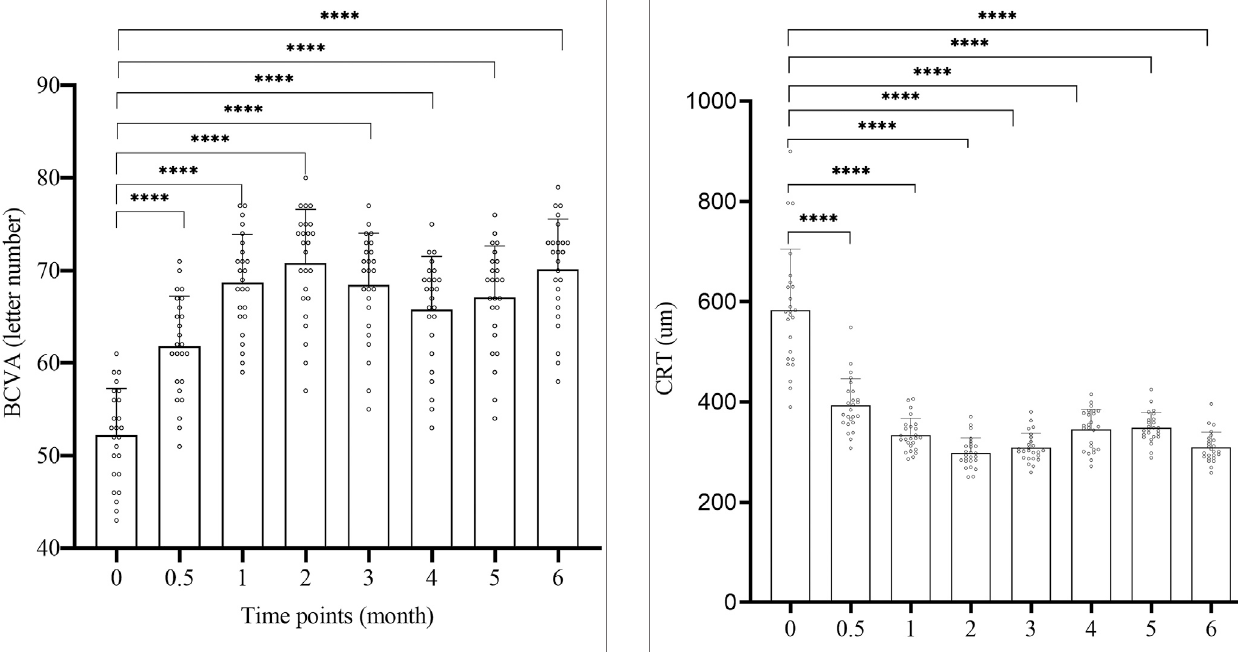
FIGURE 1 | The BCVA change of each time. BCVA: best corrected visual acuity. 0: pre-op, 0.5: 2w post-op, 1: 1 m post-op, 2: 2 m post-op, 3: 3 m post-op, 4: 4 m post-op, 5: 5 m post-op, 6: 6 m post-op. ****: Comparison between two time points p < 0.0001.